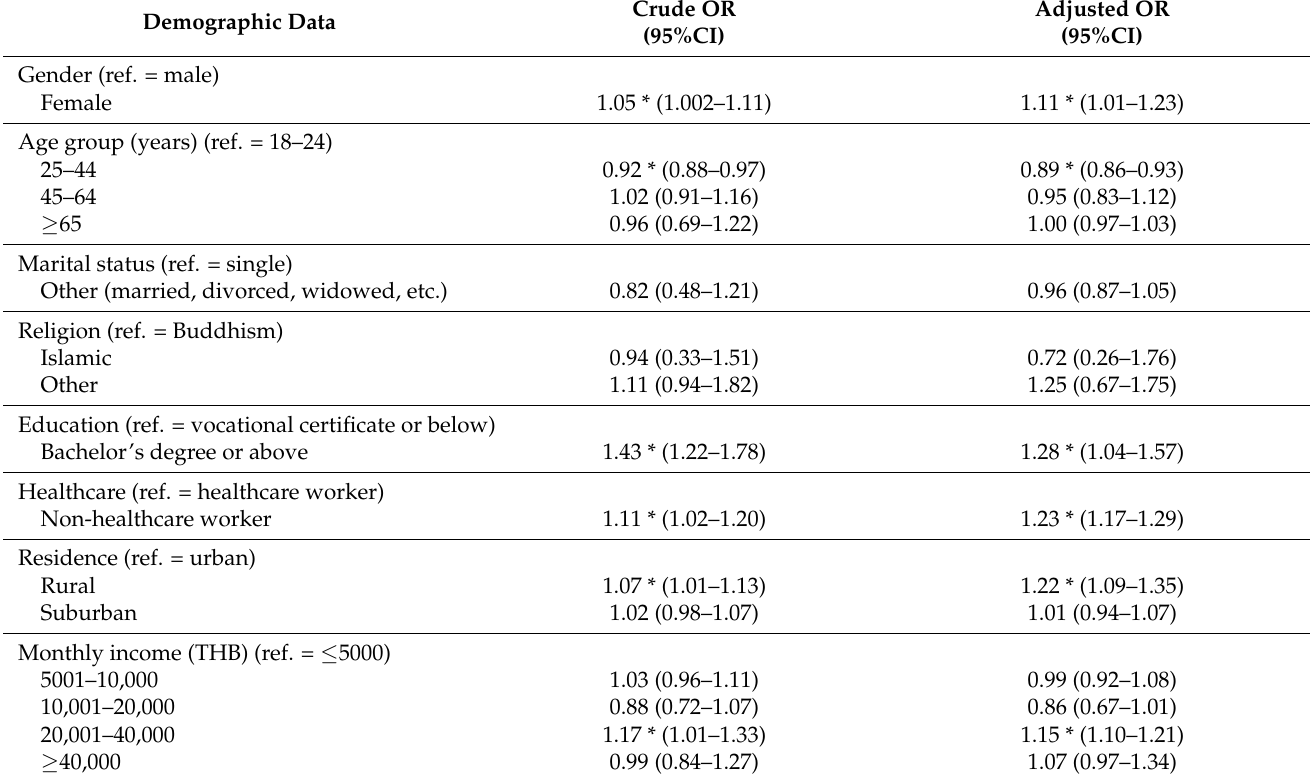
Table 3. Logistic regression model predicting COVID-19 vaccine hesitancy (n =